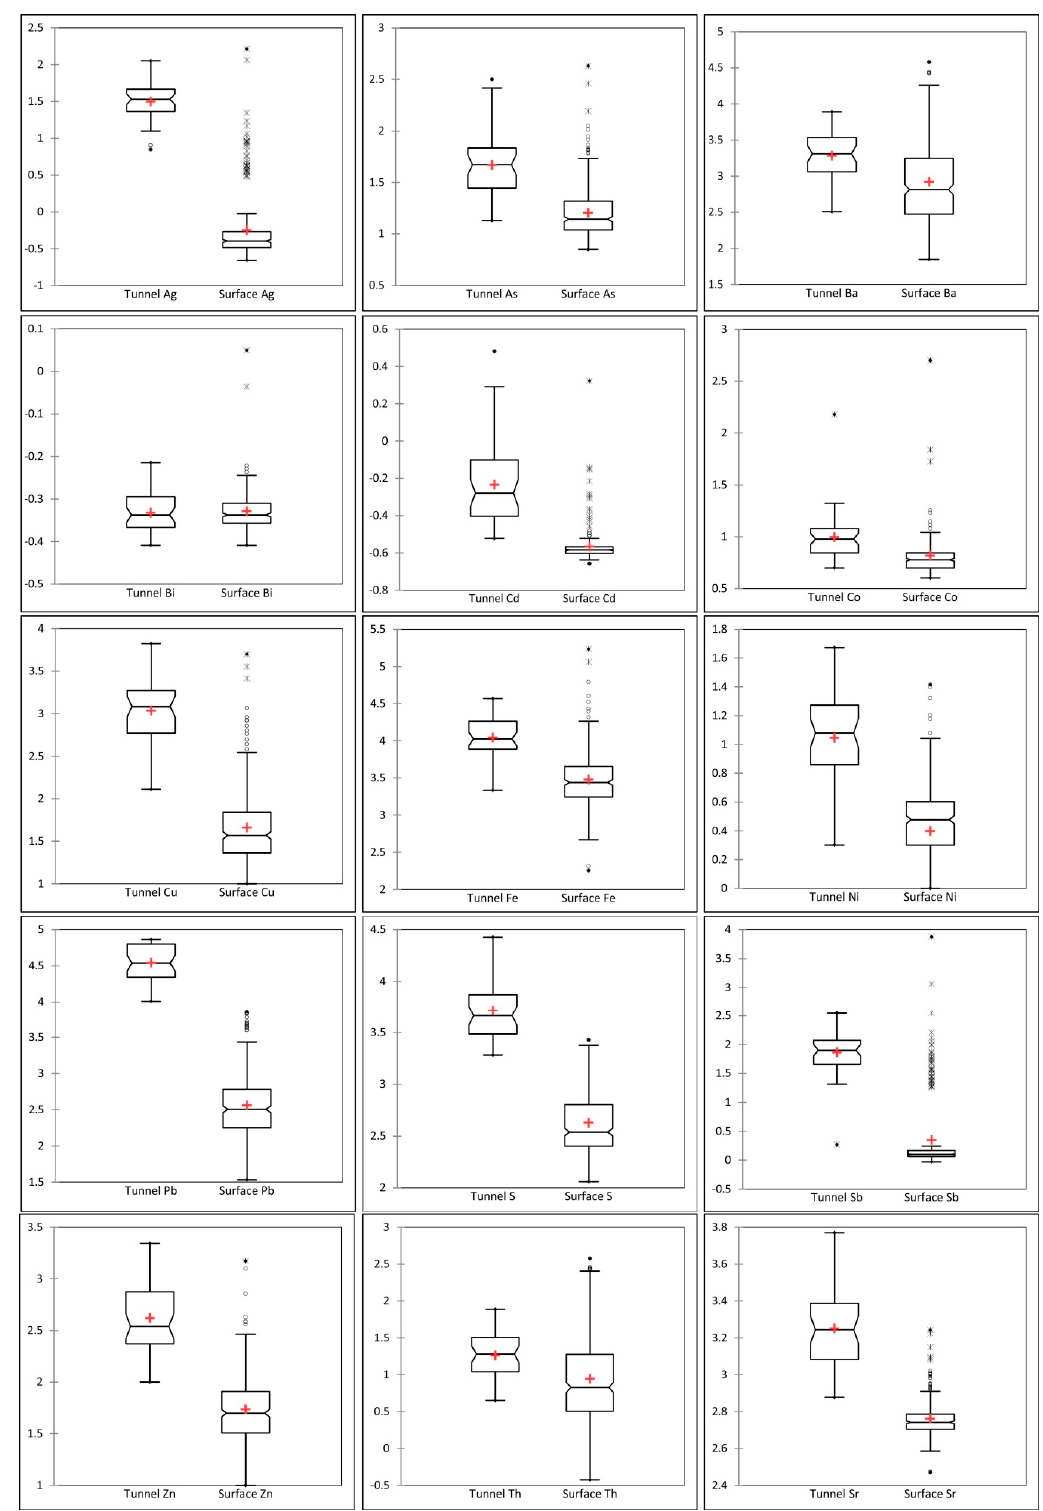
Figure 5. Box-plot of anomalous element contents (data are in ppm transformed to base 10 logarithms) in the surface (n = 302) and tunnel (n = 42) specimens in Block A of the Ravanj deposit.